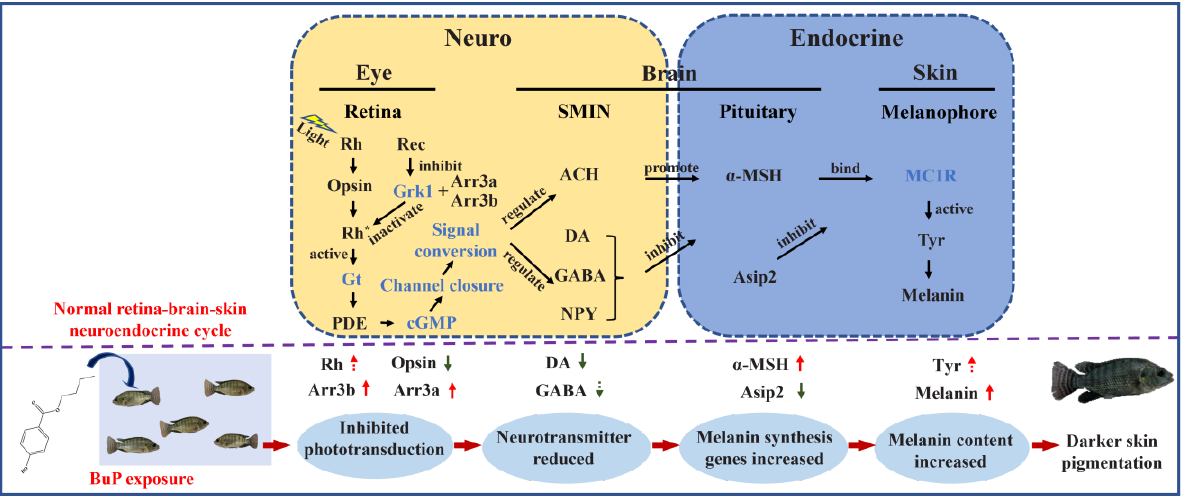
Figure 6. Schematic overview of underlying molecular mechanism of BuP-induced darker skin pigmentation in Nile tilapia.